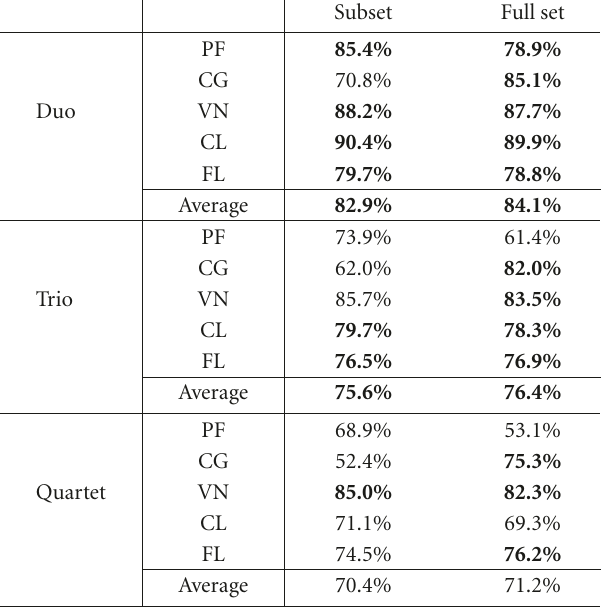
Table 12: ANOVA SS = sum of squares, DF = degrees of freedom, DR = dimensionality reduction.